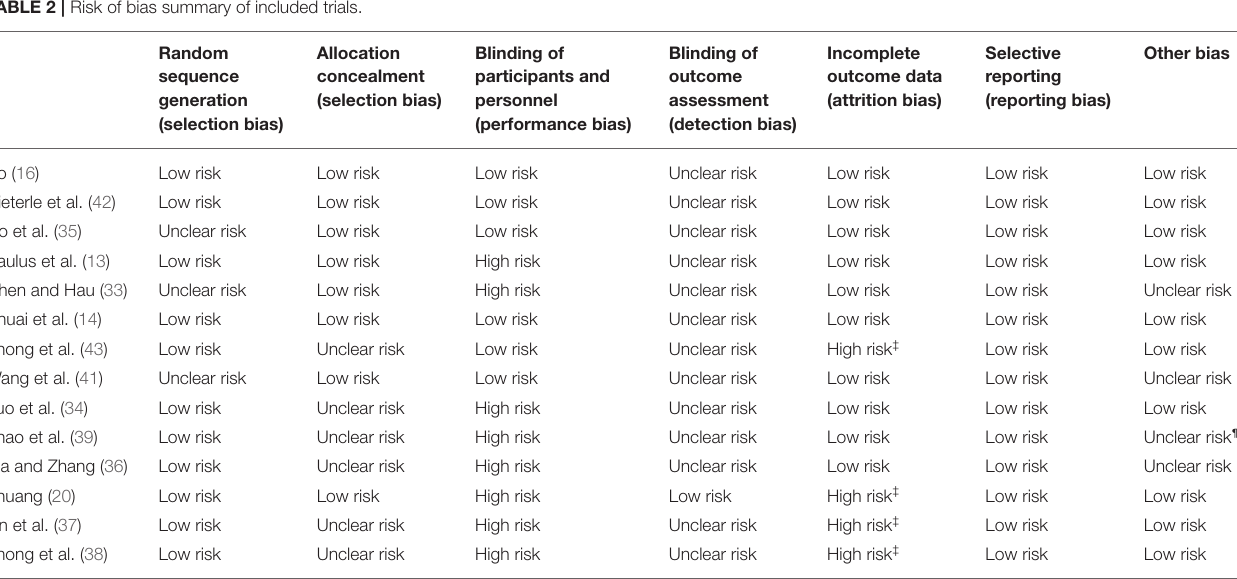
TABLE 2 | Risk of bias summary of included